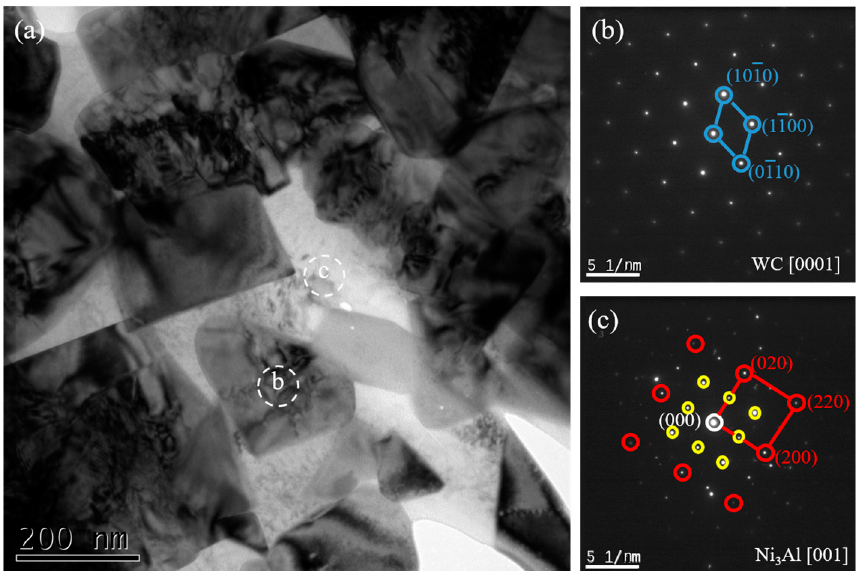
Figure 7. TEM image of the WC-10Ni 3 Al specimen using C 6 H 12 and selected area electron diffraction patterns obtained from the different phases. ( a ) local area; ( b , c ) selected area diffraction pattern (SADP) corresponding to the white dotted circles.